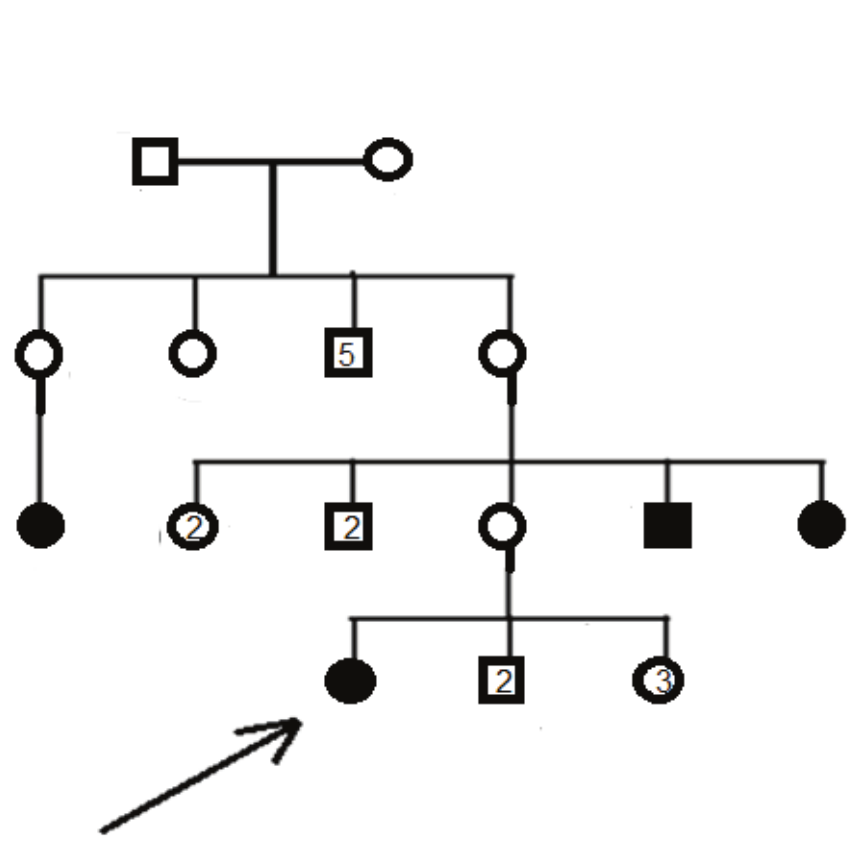
Figure 5 : Pedigree of the fifth family from the Northern State, Sudan with familial Bell’s palsy with four affected individuals (three female and one male) across two generations. The black arrow shows the index case. ( Note: The numbers inside the circles and rectangles indicate female or male family members in different generations and their subsequent generations unaffected by Bell’s palsy.